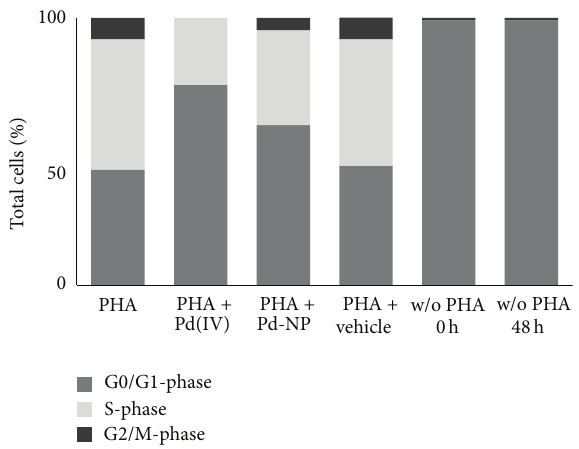
Figure 4: Cell cycle analysis of human PBMCs exposed to Pd-NP. PBMCs ( 𝑛 = 3 ) were cultivated in the presence or absence of PHA for 48 hours and after being exposed or not to Pd-NP (10 𝜇 g mL −1 ) or Pd(IV) ion (50ng mL −1 ) for 48 hours. For comparison, an equal volume of vehicle was used in parallel cultures. The proportion of cells in the different phases was quantitated using ModFit software and represented with partitioned bars as the average of three experiments. G0/G1-phase: dark grey; S-phase: light grey; G2/M- phase: